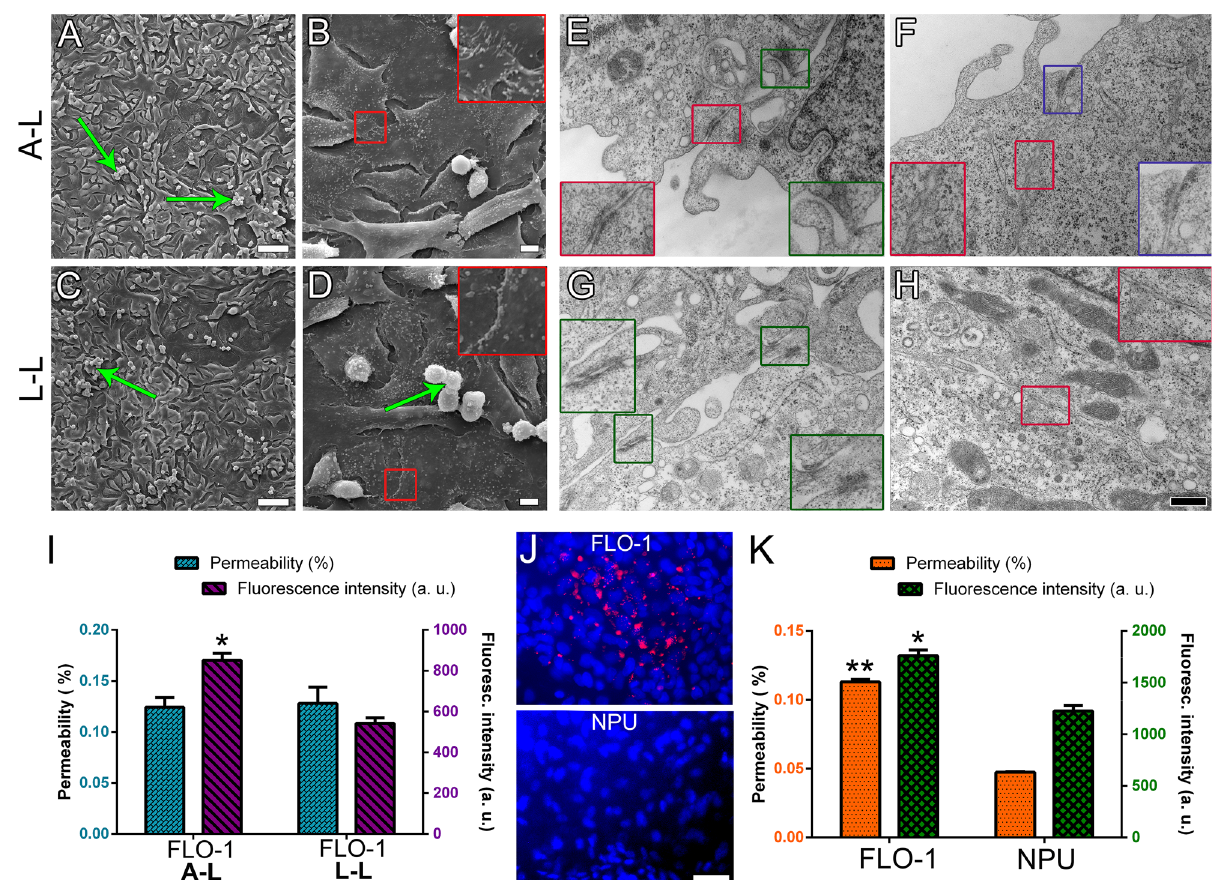
Figure 9. Ultrastructural and permeability analysis of short-term (1wk) FLO-1 in vitro models. Cells were grown on porous membranes in A-DMEM medium at the A–L and L–L interfaces for 1 wk. ( A–D ) SEM analysis shows polygonal FLO-1 cells and occasionally small cell clusters (green arrows) at both interfaces. Large insets framed with red lines are 200% enlarged images of the corresponding small red- framed insets. ( E–H ) TEM analysis shows that FLO-1 cells are connected by anchoring junctions (green insets), adherent junctions and desmosomes (red insets), and immature tight junctions (blue inset). Cells maintained at the A–L are more frequently attached via developing tight junctions than at the L–L interface. Large insets framed with green / red/purple/blue lines are 100% enlarged images of corresponding small green/ red/purple/blue framed insets. ( I , K ) Quantification of permeability and fluorescence intensity of iNANO-RITC nanoparticles in FLO-1 and normal porcine urothelial (NPU) cells. The bars represent the average fluorescence values of iNANO-RITC nanoparticles in basal chamber expressed as % of fluorescence of nanoparticles added to the apical chamber (blue bars ( I ), orange bars ( K )) and average fluorescence intensity in arbitrary units (a. u.) (purple bars ( I ) and green bars ( K )). ( I ) Permeability of iNANO-RITC nanoparticles in FLO-1 cell grown at the A–L interface is similar to that at the L–L interface. The average fluorescence intensity is higher in FLO-1 models at the A–L interface (* p ≤ 0.05; un-paired Student’s t-test, n = 4). ( J ) Endocytosed iNANO-RITC nanoparticles (red) in FLO-1 and normal porcine urothelial (NPU) cells maintained at the L–L interface. ( K ) The permeability and fluorescence of endocytosed iNANO-RITC nanoparticles is significantly higher in FLO-1 cells compared to NPU cells (* ≤ 0.05; ** p ≤ 0.00001; un-paired Student’s t-test, n = 12 for permeability measurements and n = 4 for fluorescence intensity measurements). Scale bars, 100 µm ( A , C ), 50 µm ( J ), 10 µm ( B , D ), and 400 nm ( E – H